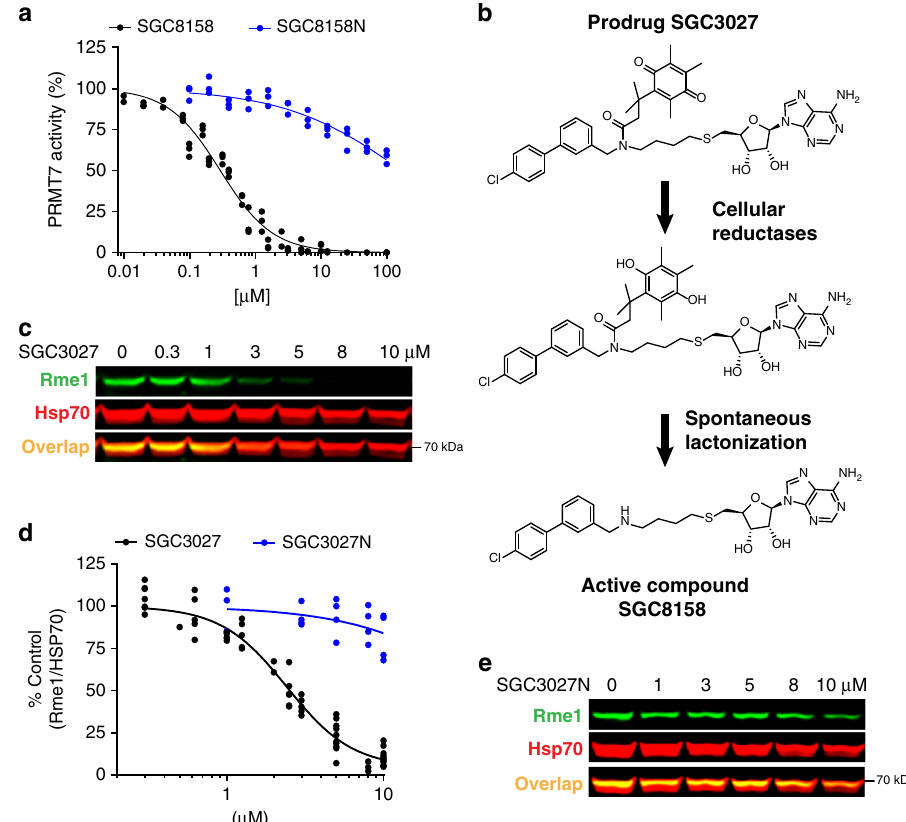
Fig. 5 SGC3027 inhibits HSP70 methylation in cells and its active component SGC8158 methylation in vitro. a SGC8158 inhibits PRMT7 methylation of HSPA8 in vitro. SGC8158 IC 50 = 294 ± 26 nM (2 biological replicates, each with technical n = 3, mean ± SEM), SGC8158N IC 50 > 100 µ M ( n = three technical replicates). The methylation assay was performed in the presence of ATP ( n = 3 technical replicates). b SGC3027 is a prodrug cellular inhibitor of PRMT7 as illustrated by the prodrug conversion to the active component in cells. c SGC3027 inhibits PRMT7-dependent HSP70 monomethylation in C2C12 cells. Cells were treated with the compound for 2 days. The experiment was repeated four times with similar results. d Quanti fi cation of SGC3027 and SGC3027N effects on HSP70 monomethylation in C2C12 cells. The graphs represent non-linear fi ts of Rme1 signal intensities normalized to intensities of HSP70. SGC3027: n = 11, four separate experiments, IC 50 = 2.4 ± 0.1 µ M; SGC3027N: n = 4 technical replicates, IC 50 > 40 µ M (mean ± SEM). e A representative blot for SGC3027N effects on HSP70 methylation. Rme1 — arginine monomethylation. The experiment with 3 and 10 µ M SGC3027N concentration was repeated three times with similar results. Source data are provided as a Source Data fi